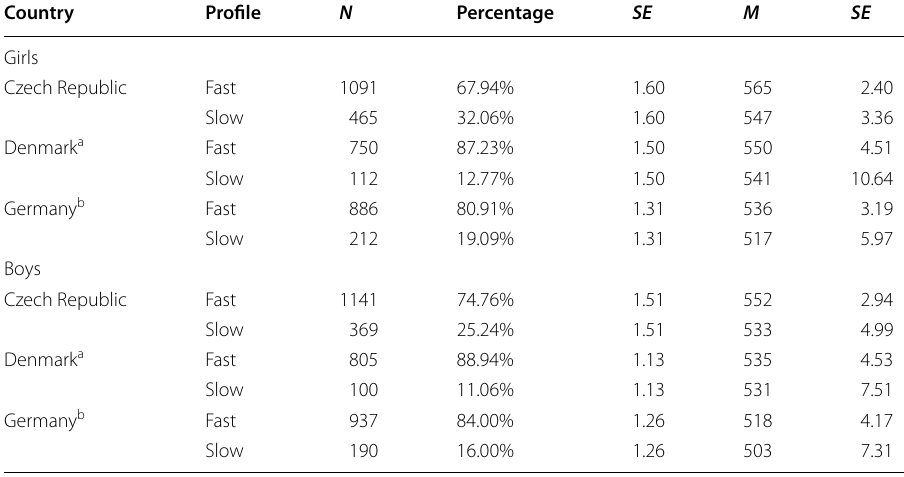
a Did not meet sample requirements